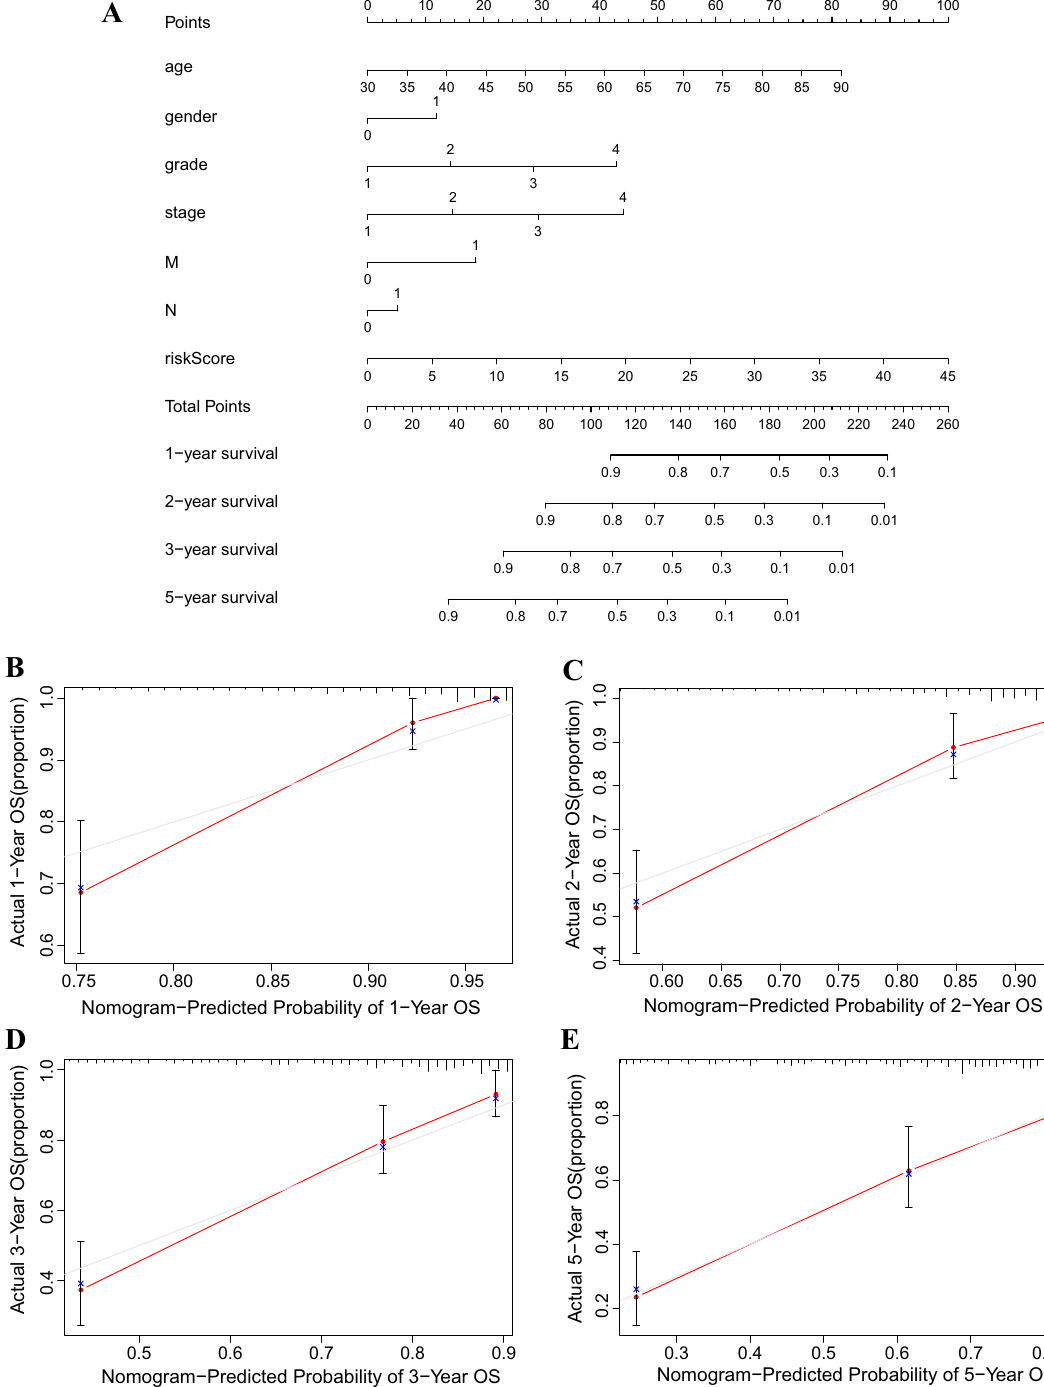
Figure 4. Construction and verification of the nomogram. ( A ) Nomogram combining clinicopathological variables and risk scores to predict overall survival at 1, 2, 3, and 5 years of patients with ccRCC. ( B – E ) The calibration curves testing the agreement of actual overall survival rates with predicted survival at 1, 2, 3 and 5 years. N, lymph nodes; ccRCC, clear cell renal cell